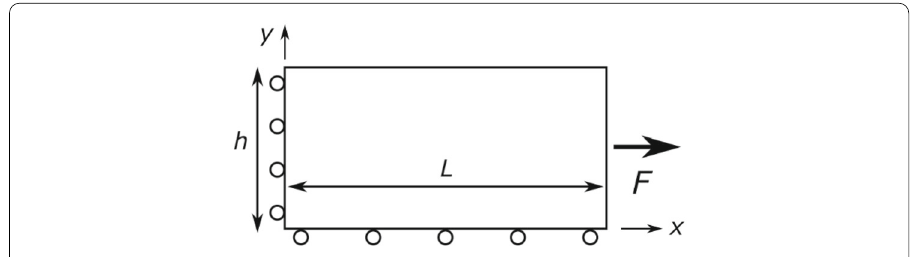
Fig. 5 Example of the simple isotropic plain specimen in tension: definition of the dimensions of the domain and the applied boundary conditions in the ( x,y ) coordinate system